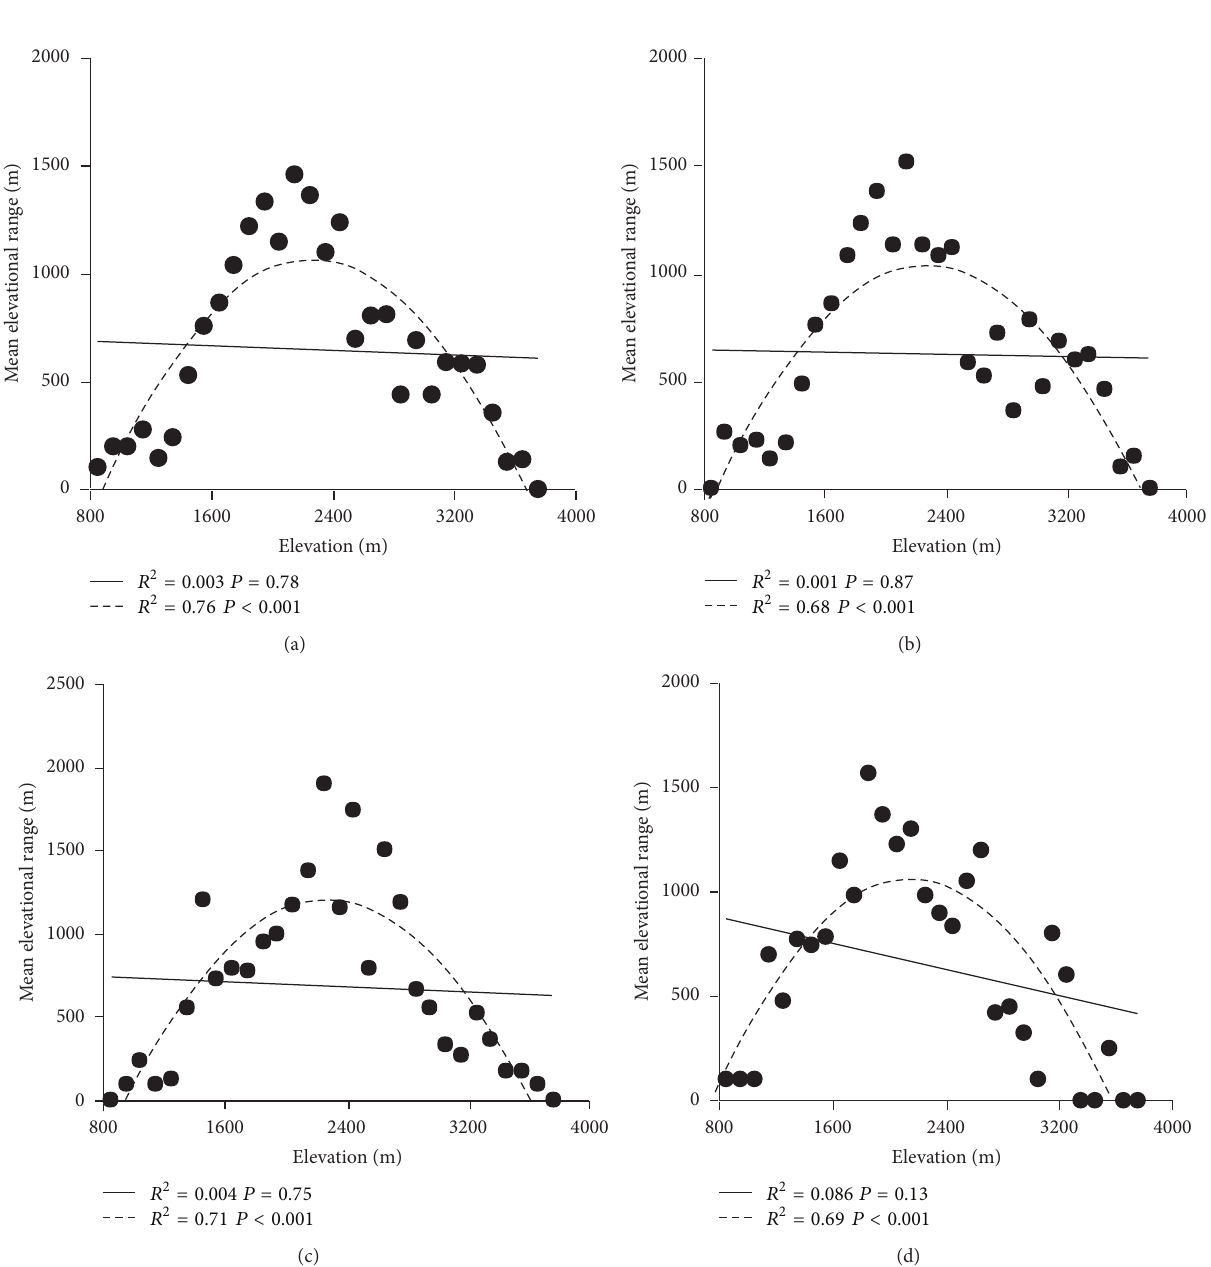
low ( 𝑅 2 = 0.003, 0.001, 0.004, 0.081 for overall plants,